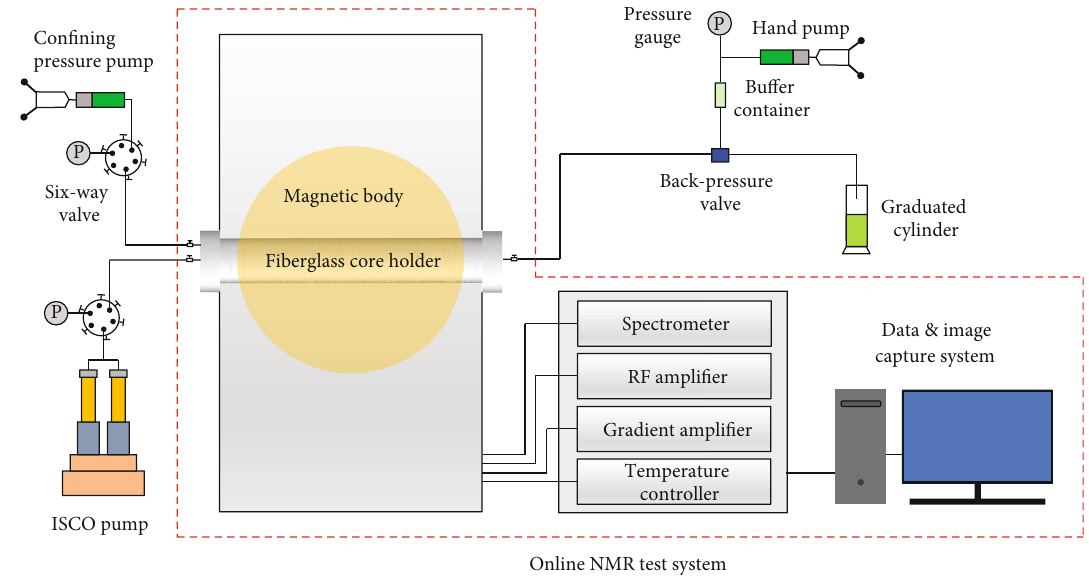
Figure 2: Setup for the formal experiments. Table 4: Permeability and porosity information.